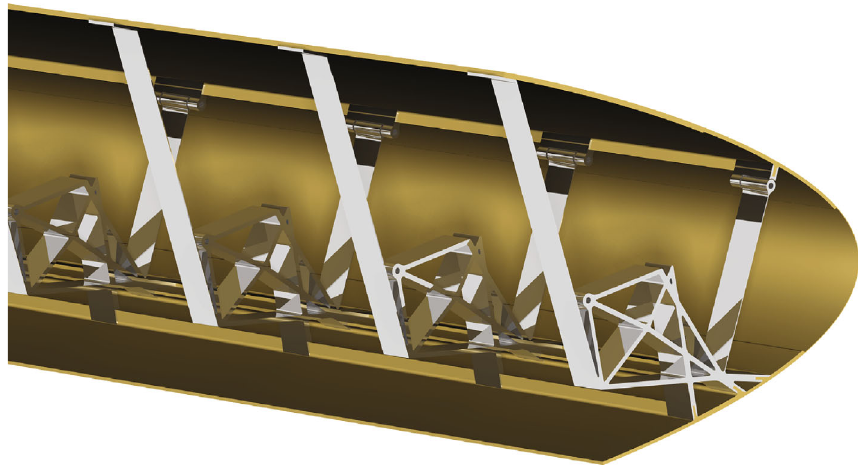
Figure 16: Detail of the assembly between the rib and the skin.